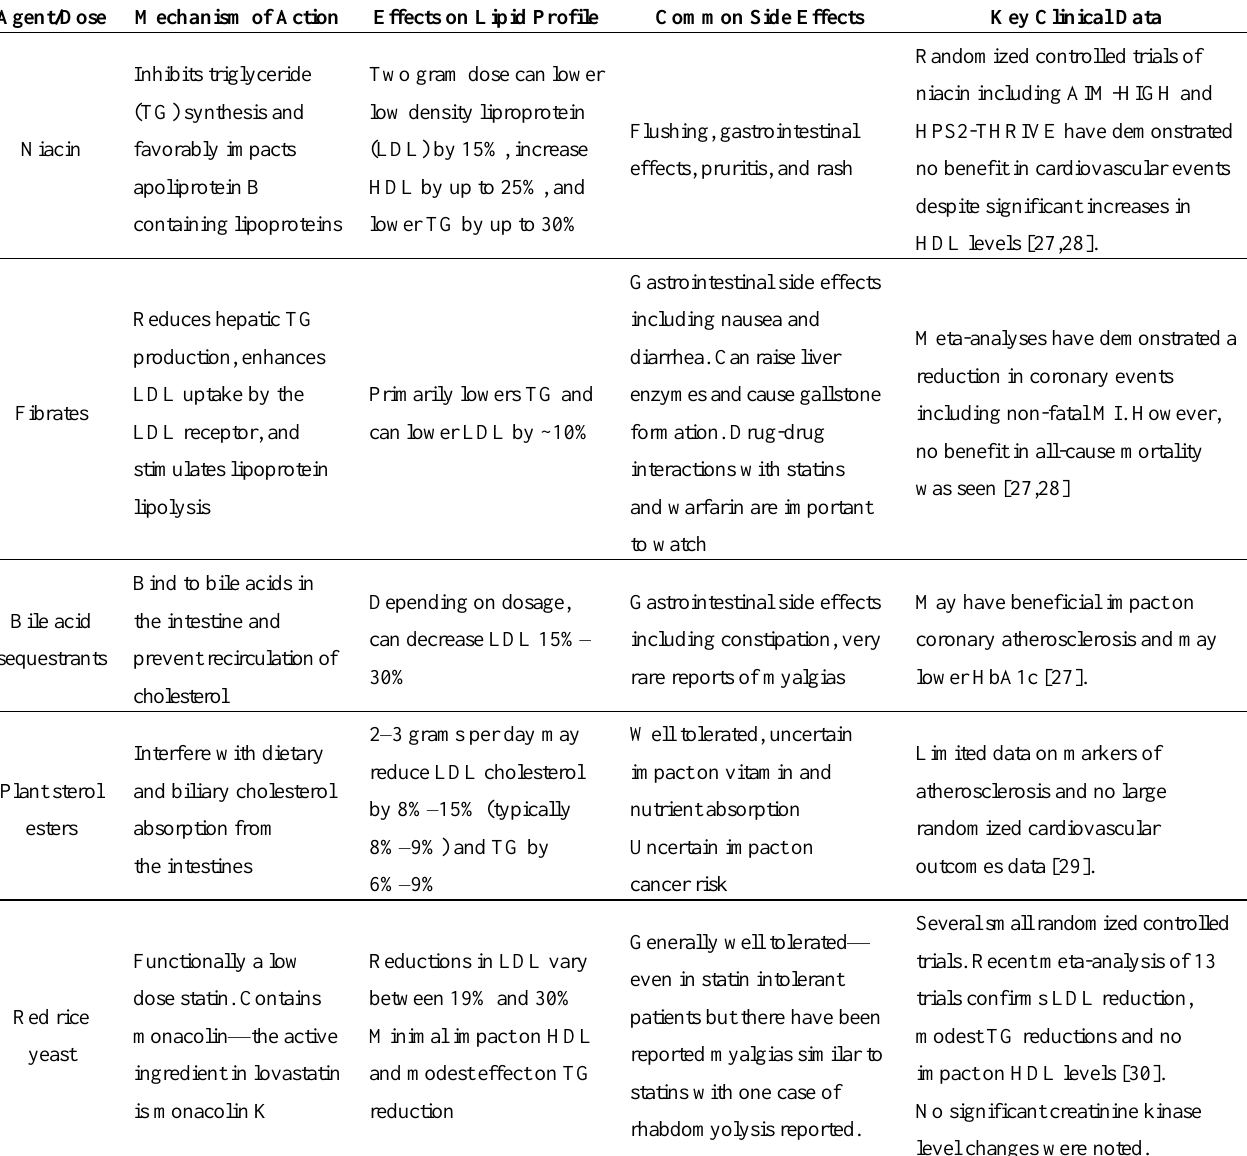
Table 1. Agents commonly used for the management of